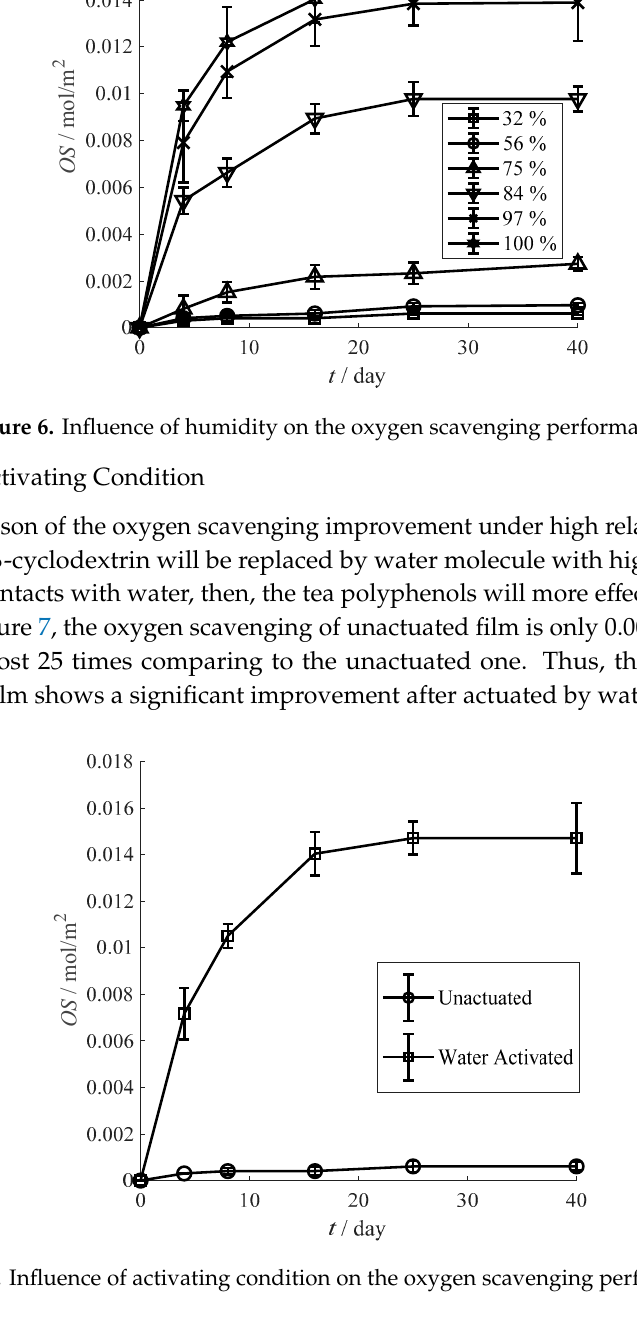
Figure 8. Influence of temperature on the oxygen scavenging performance.